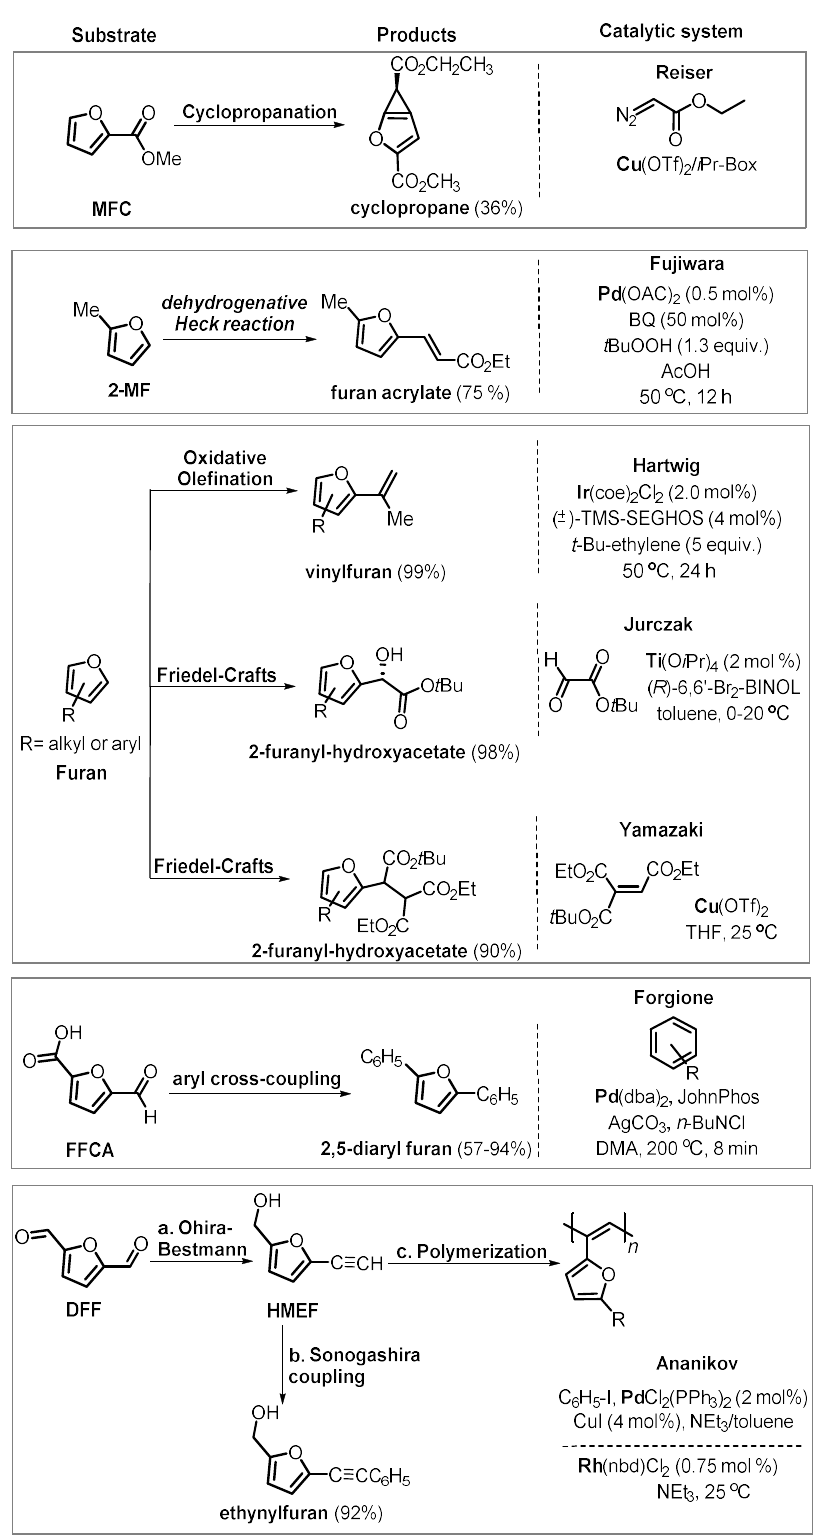
Figure 11. Catalytic functionalization of furanics in the presence of homogeneous catalytic systems. Other synthetic methodologies for the production of bio-based synthons, such as 2-furanyl-hydroxyacetates, have been reported. For example, Jurczak published examples of efficient Friedel − Crafts reactions of a series of furans with alkyl glyoxylates